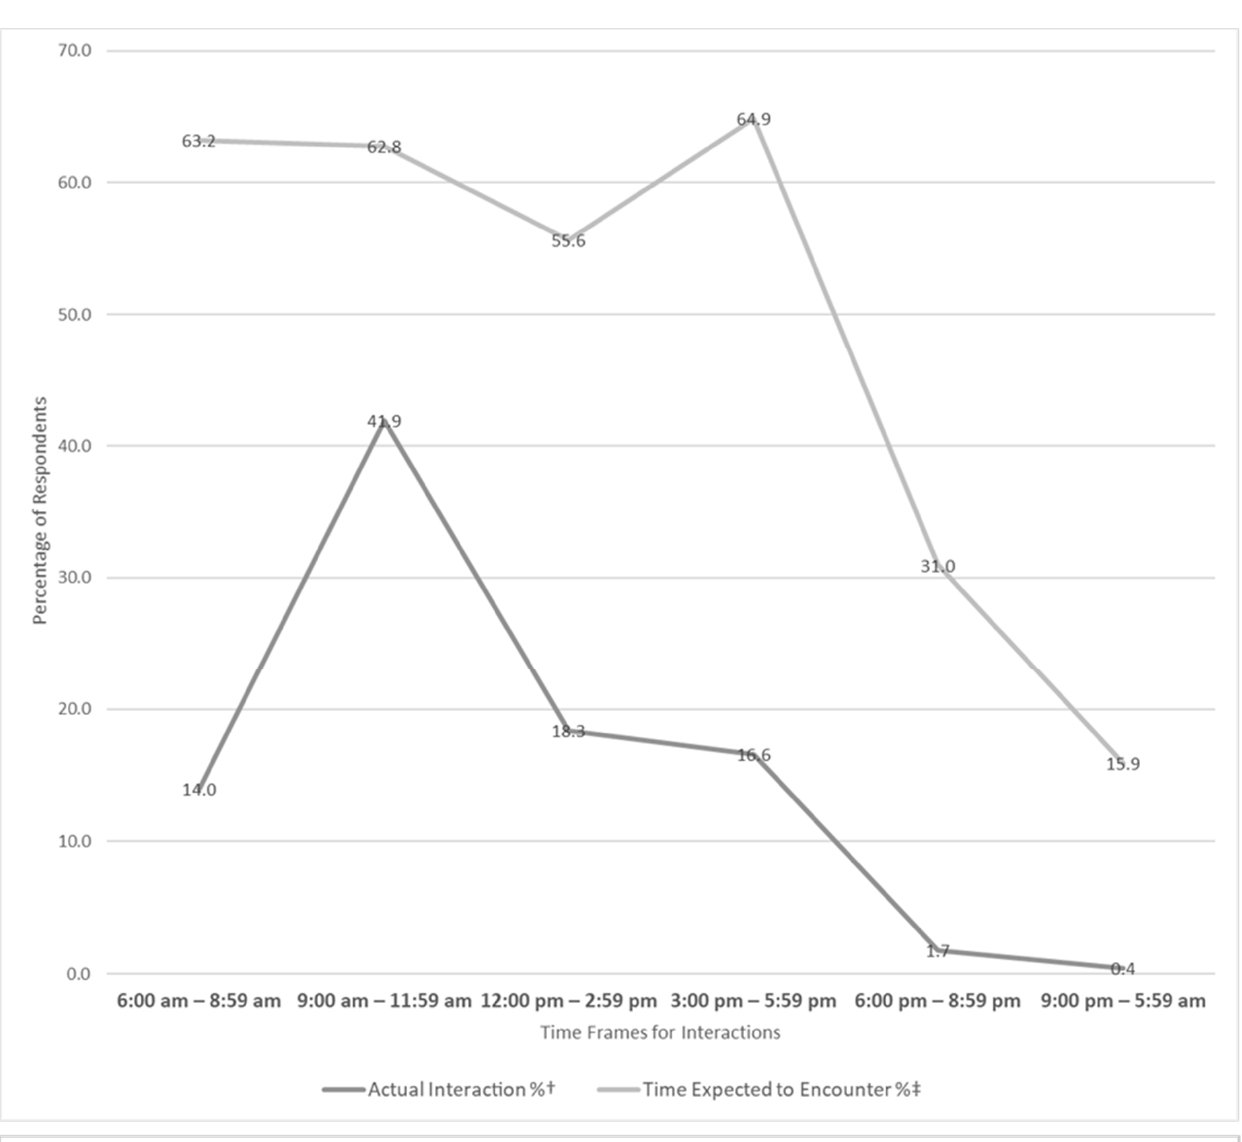
Figure 1. LAV Interactions: expected time of interactions and actual recent interaction times.